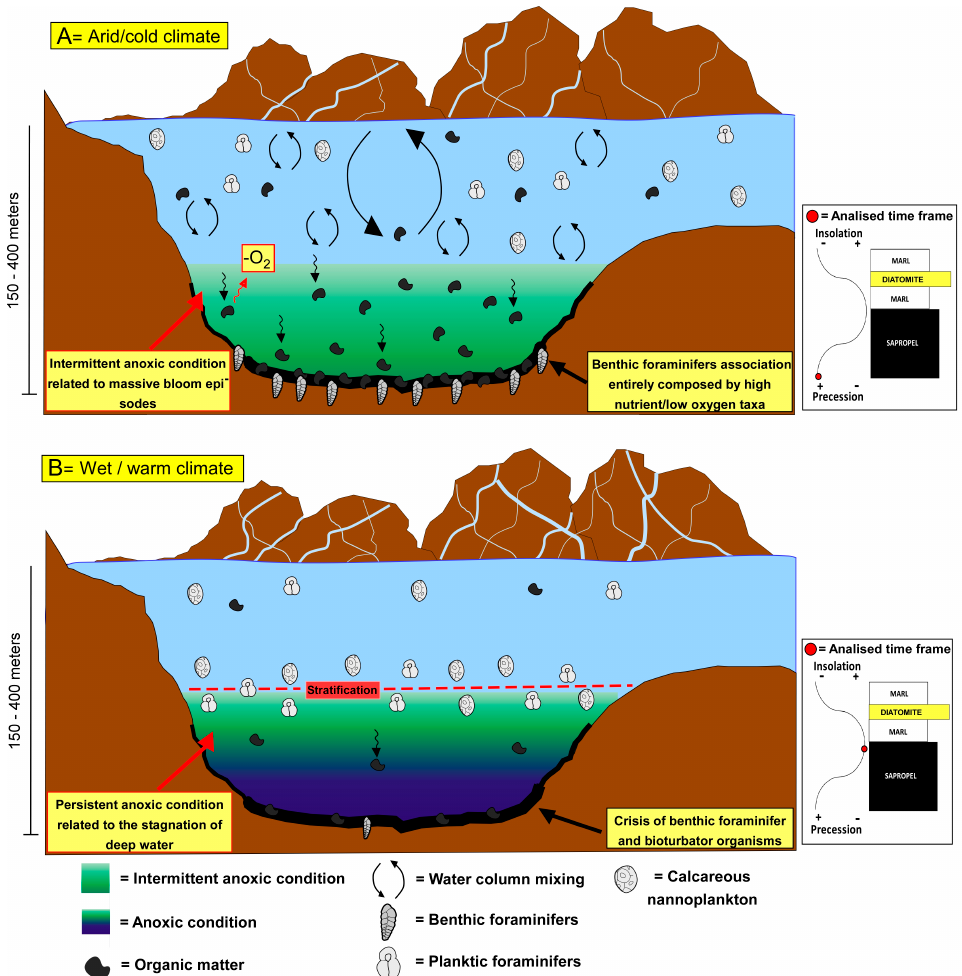
Figure 6. Sketch showing the environmental condition triggering the Messinian sapropel deposition in the Sorbas Basin based on the proxies shown in Figure 4. ( A ): During insolation minima (precession maxima), the cold temperature promoted vigorous vertical mixing and distributed the nutrient throughout the photic zone, thus stimulating primary productivity. This resulted in an increase of the organic carbon rain to the seafloor which, once re − mineralised, decreased the bottom oxygen content. ( B ): During insolation maxima (precession minima), the increase in both temperature and continental runoff favoured the stratification of the water column. Primary productivity was mostly located in the deep photic zone, where a DCM occurred. At the sea bottom, persistent anoxic conditions related to the stagnation of deep water occurred. This environmental setting led to a strong reduction or even a disappearance of benthic and bioturbator organisms.